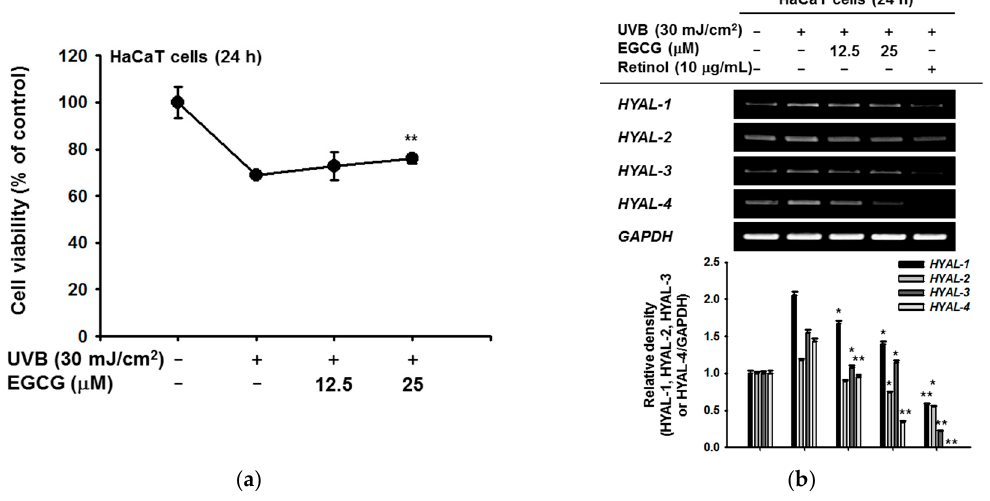
Figure 2. Effect of EGCG on skin hydration via inhibition of NMF degradation. ( a ) under UVB irradiation, the viability of HaCaT cells with and without EGCG was measured by MTT assay; ( b ) mRNA expression of HYAL-1,2,3 , and 4 was determined by RT-PCR in HaCaT cells after irradiation with UVB (30 mJ/cm 2 ) for 24 h and treatment with EGCG (0–25 μ M) or retinol (10 μ g/mL). The relative density of HYAL expression was also measured. Statistical significance of results (( a ) and bottom panel of ( b )) was evaluated by Kruskal–Wallis/Mann–Whitney test. All data are expressed as means ± SD of an experiment. * p < 0.05 and ** p < 0.01 compared with control group.